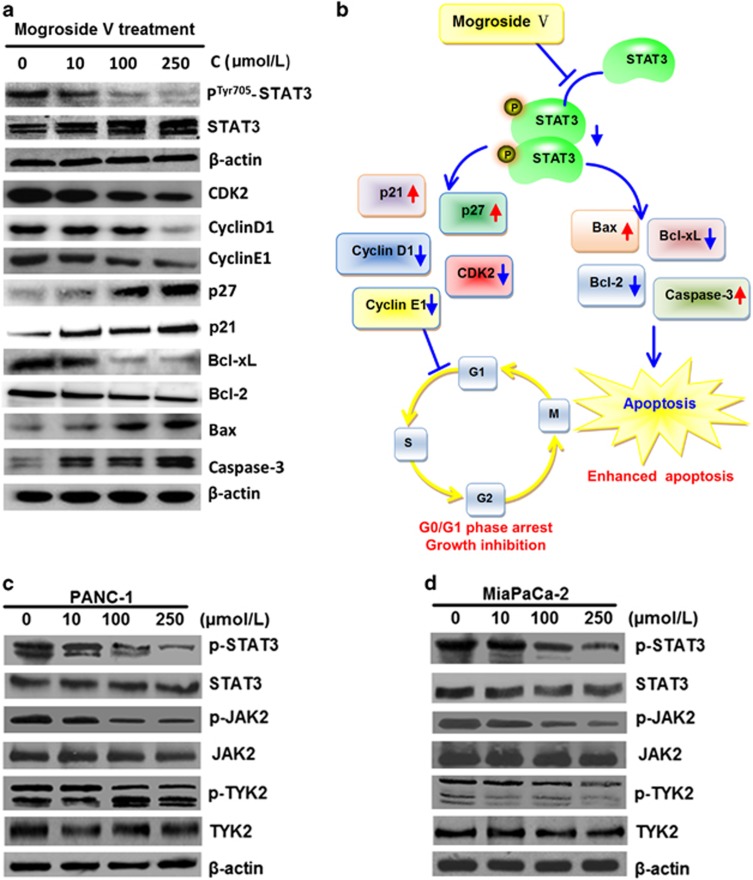
The effect of mogroside V on the STAT3 pathway. PANC-1 cells were exposed to various concentrations of mogroside V for 24 h and the target proteins were detected by immunoblotting using specific antibodies. (a) Phosphorylation of STAT3 (p-STAT3) and the expression of proteins downstream of the STAT3 pathway were suppressed in the mogroside V-treated cells. (b) A tentative depiction of the regulation of the STAT3 signaling pathway in PANC-1 cells by mogroside V. (c) The phosphorylation of STAT3 to p-STAT3 and protein expression of STAT3, P-JAk2, JAK2, P-TYK2 and TYK2 in mogroside V-treated PANC-1 cells and MiaPaCa-2 cells (d) were examined using western blotting. Beta-actin expression served as a loading control. The results were obtained in three independent experiments.